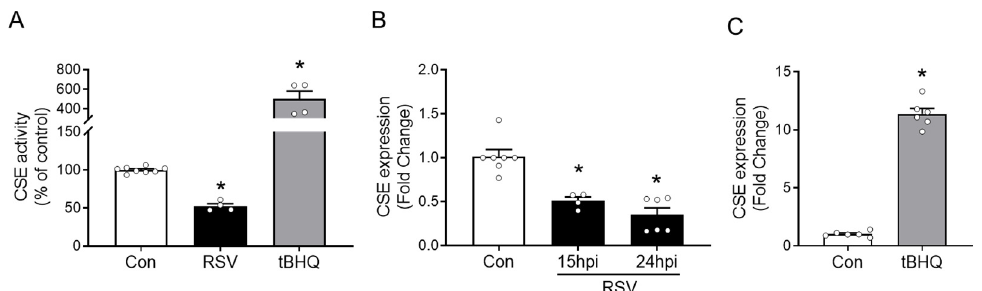
Figure 1. CSE activity and expression in response to respiratory syncytial virus (RSV) infection and tert -butylhydroquinone (tBHQ) treatment. SAE cells, either control (Con), infected with RSV for 24 h, or treated with tBHQ (25 µM) for 15 h, were harvested to measure CSE enzymatic activity, and expressed as percentage of control, as described in Materials and Methods ( A ). CSE gene expression, expressed as fold change over control, was measured in RSV-infected SAE cells at 15 and 24 h post infection (p.i.) ( B ) or in response to tBHQ (25 µM) for 15 h by RT-qPCR ( C ). Results are expressed as mean ± SEM of combined data from two independent experiments (each circle represents individual data). * p < 0.05 relative to control cells.